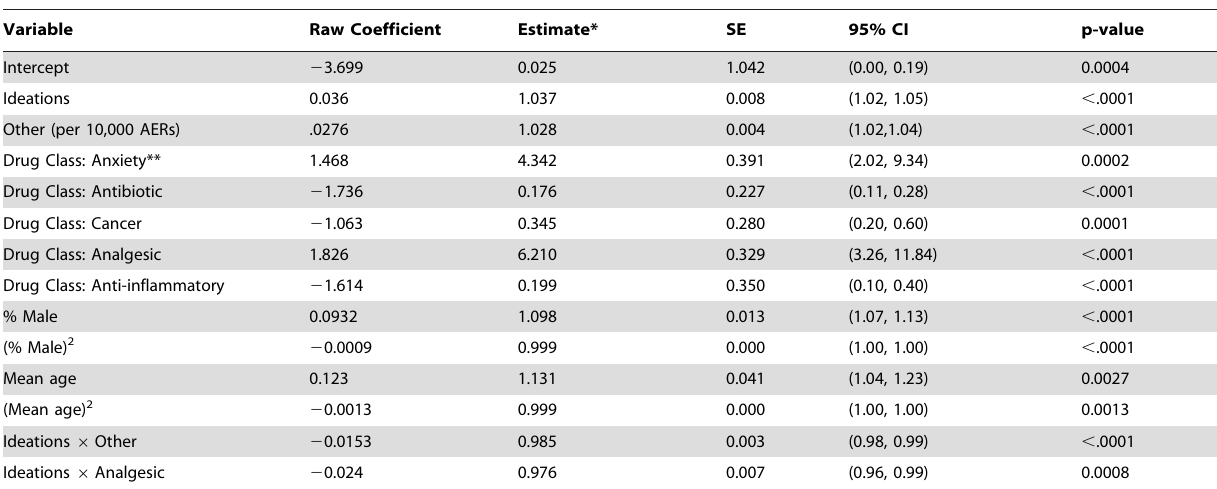
Table 5. Estimates of full